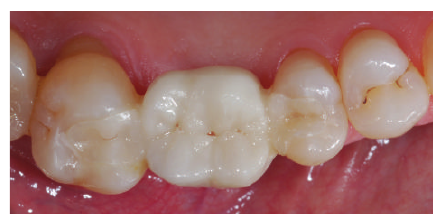
Figure 12: 2-year follow-up: occlusal